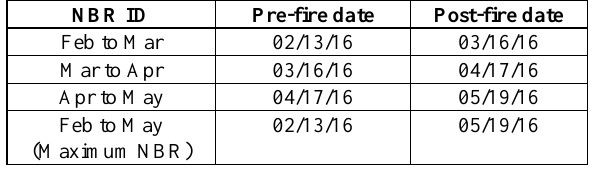
Table 1. Summary of Landsat 8 Images